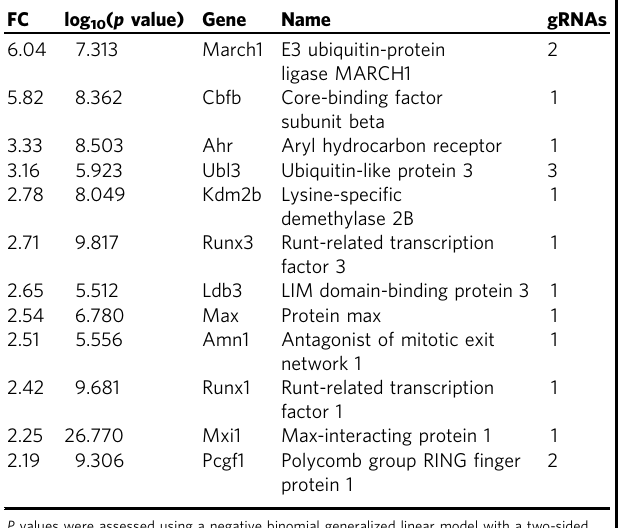
Table 1 Enriched gRNAs in the MHC II high